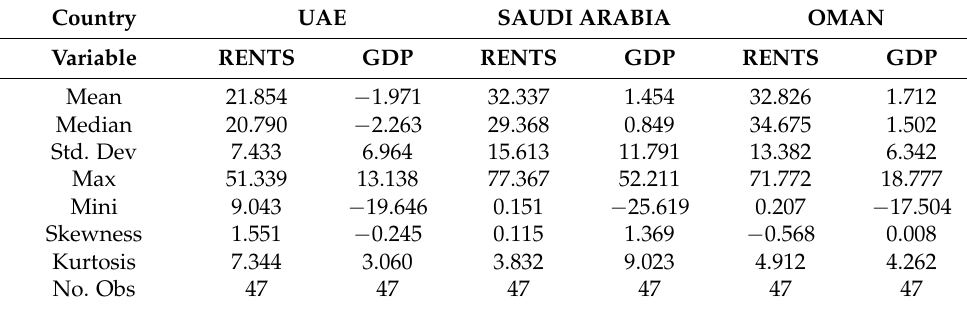
Table 1. Descriptive Statistics.